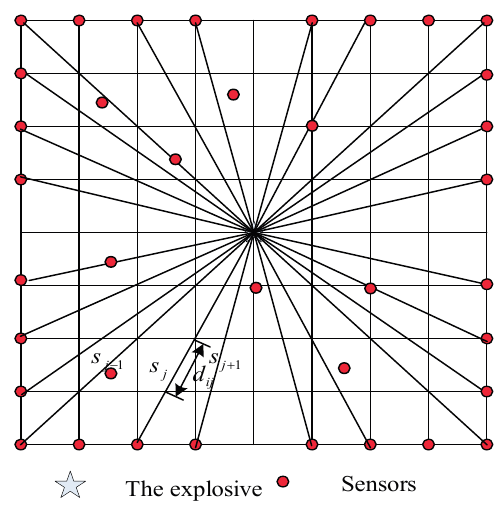
Figure 1. Illustration of travel time